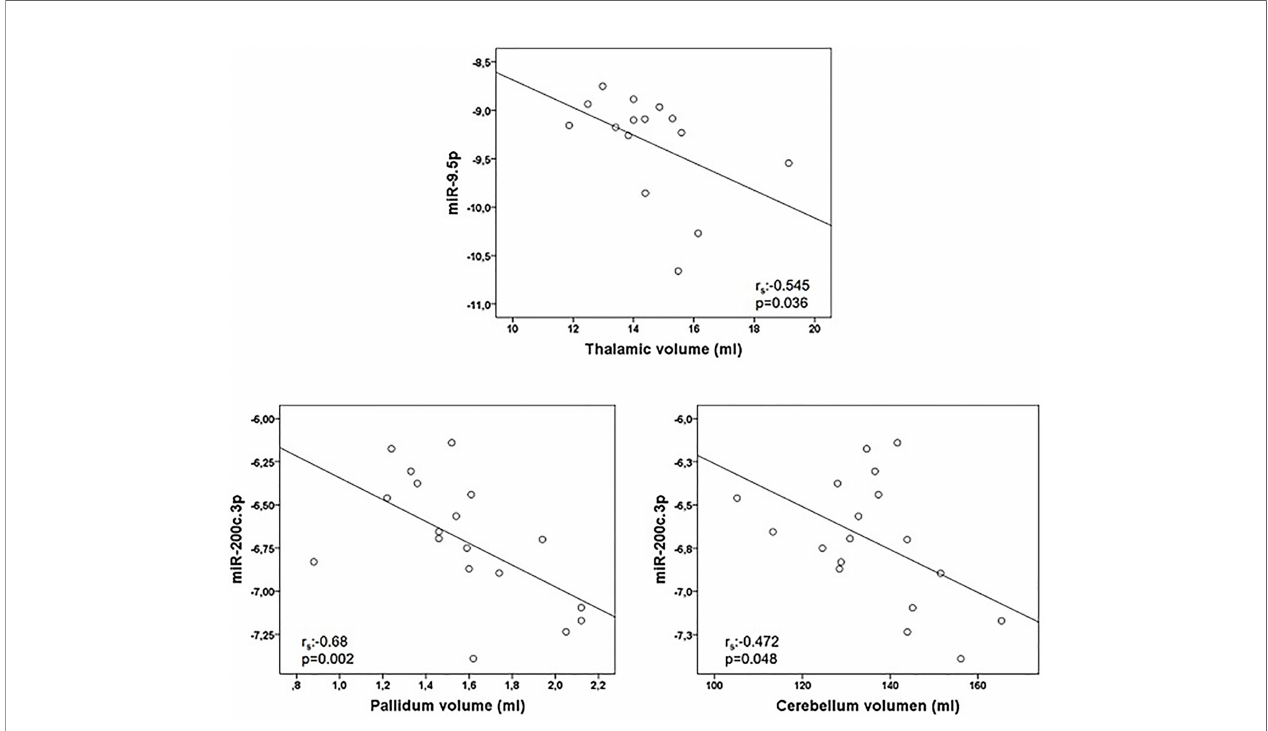
FIGURE 2 | Graphical representations of microRNAs (miRNAs) expression levels associated negatively with magnetic resonance images (MRI) variables. MiR-9.5p was analyzed in 15 multiple sclerosis patients and miR-200c.3p in 18 patients. Spearman correlation test was used for statistical analysis. r s : Spearman correlation coef fi